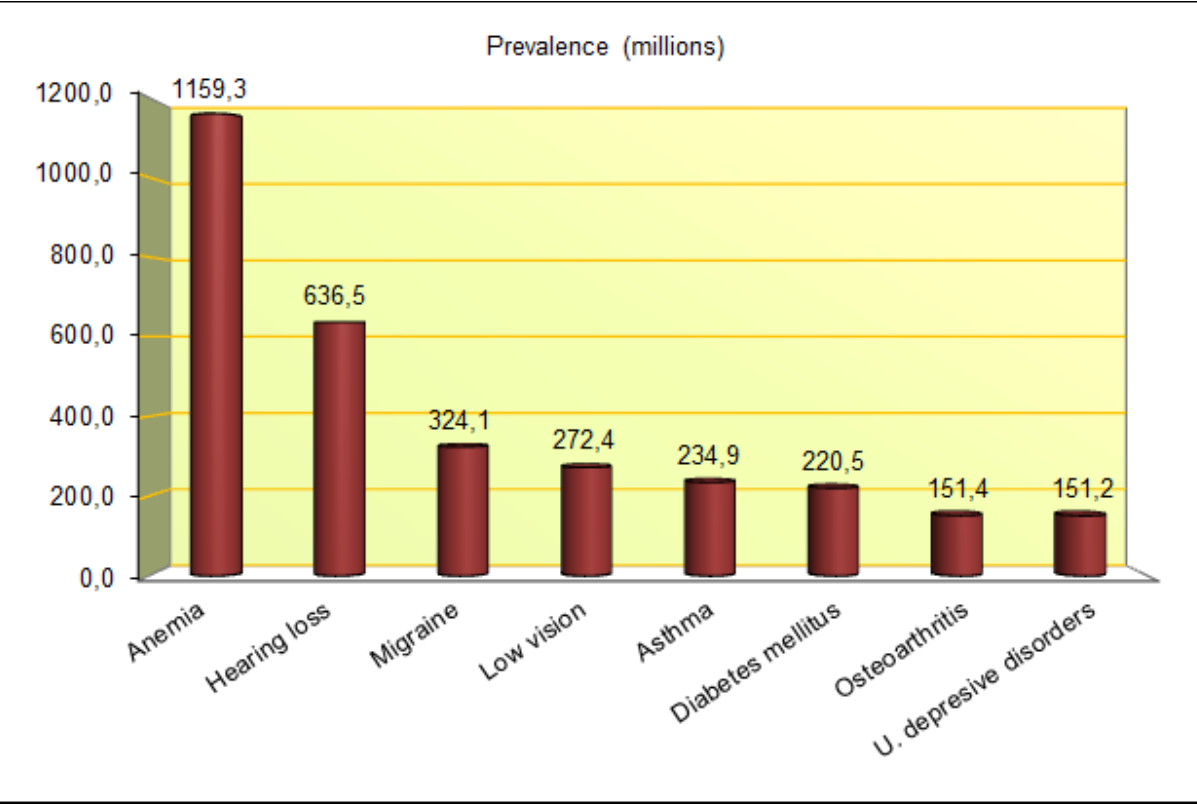
Figure 1. The 8 most prevalent conditions by the